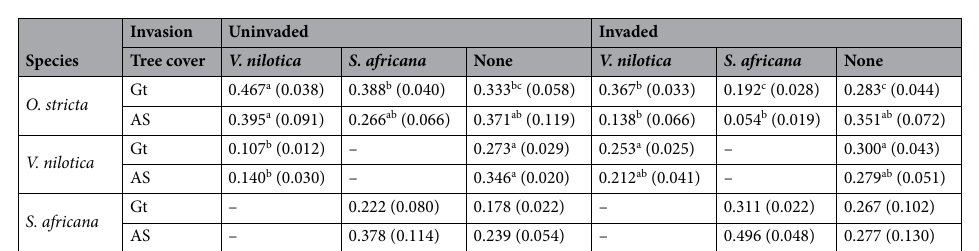
Table 4. Mean (± SE) of total germination (Gt) and speed of germination (AS) of O. stricta , V. nilotica and S. africana in patches invaded and uninvaded by O. stricta under the canopies of V. nilotica and S. africana trees and in open patches with no tree cover. Letters indicate significate differences between soils (P <